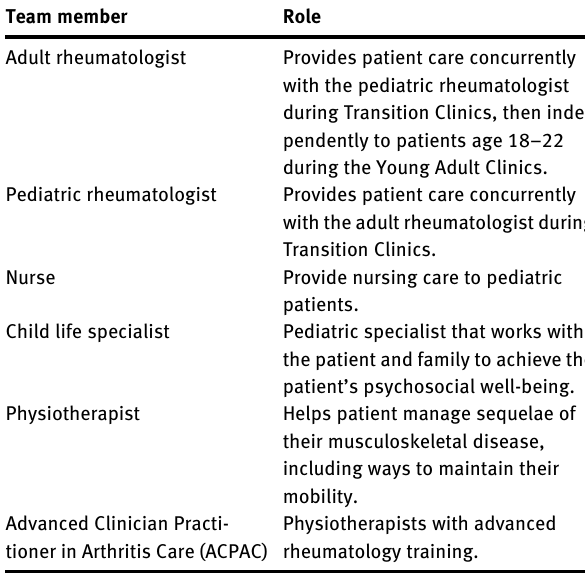
Table  : Multidisciplinary team